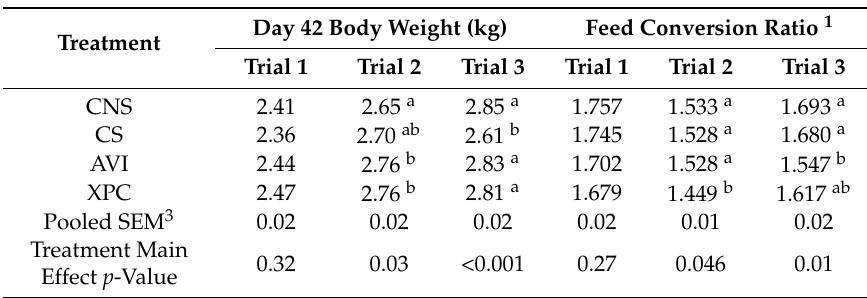
Table 4. Average individual body weight (kg) from all birds at 42 days of age and cumulative feed conversion ratio from days 0 to